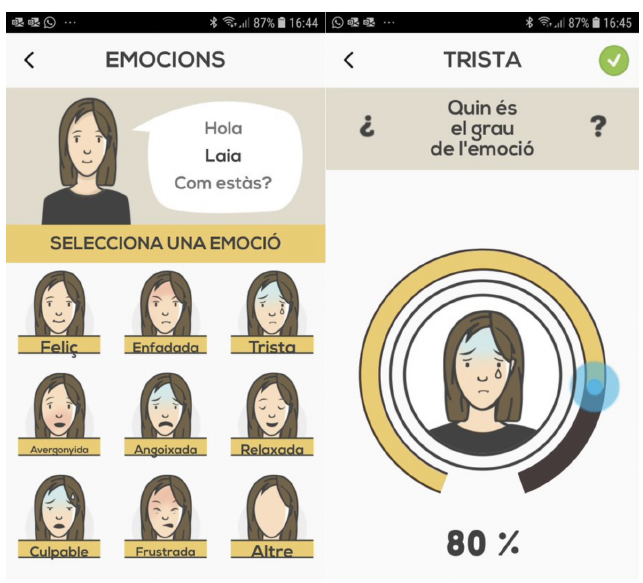
Figure 1. On the left , a screenshot with the list of emotions to report to the system. On the right , a detail on how to report the grade of the emotion by means of a sliding button (the text in the App is in Catalan. See the translated names of the emotions in Table